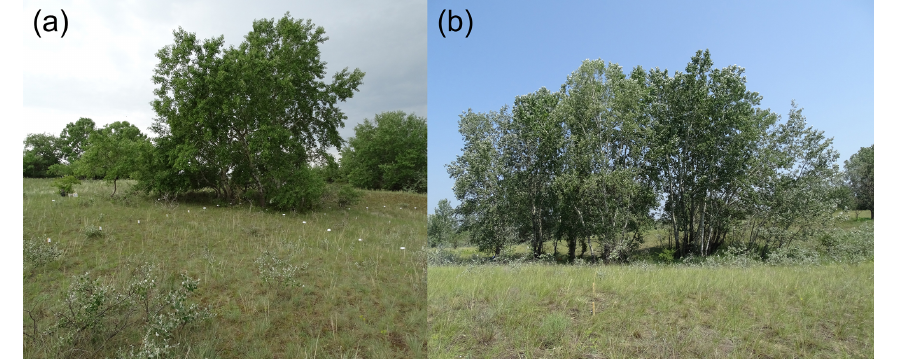
Figure 1. Study sites with the first grove (a) and the second grove (b) .